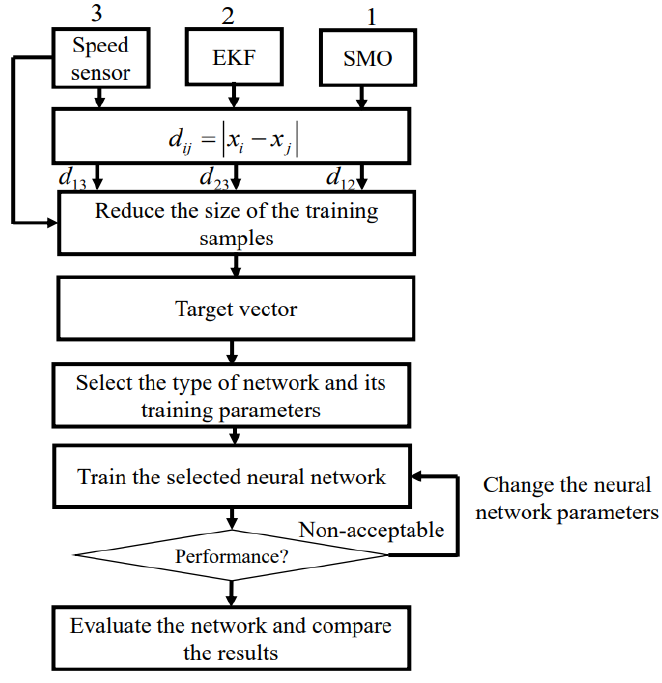
Figure 9. The flowchart of the NV.